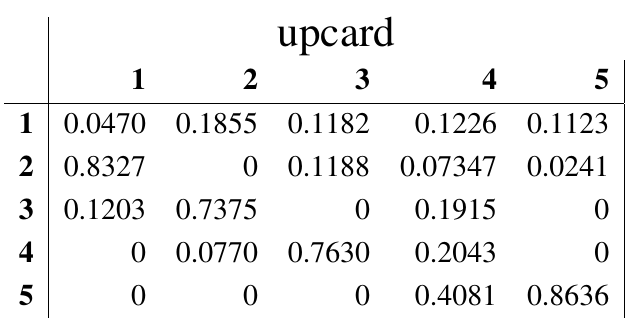
Table 1. Optimal strategy at the first move, N = 5